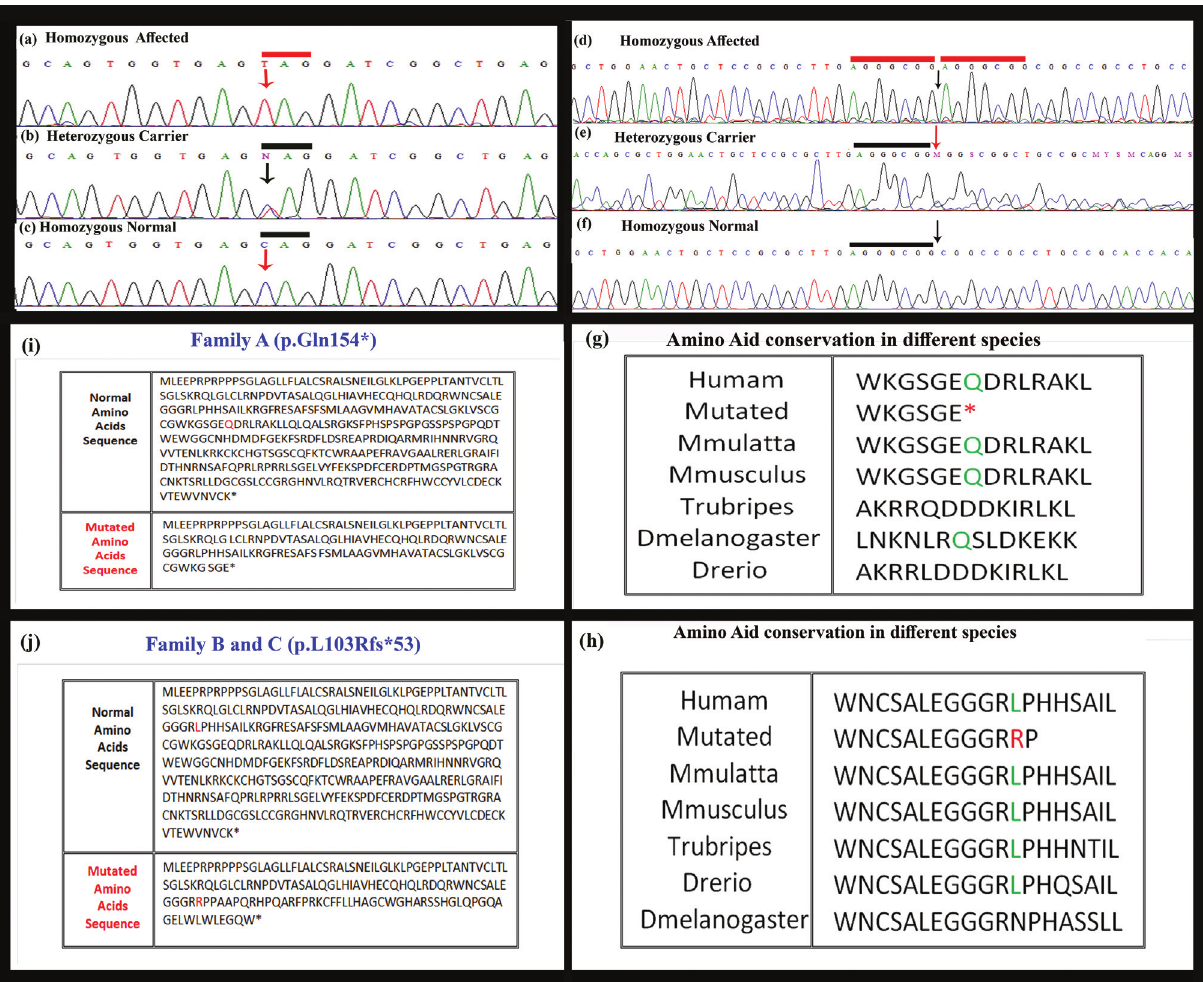
Figure 3 - Sequence analysis of WNT10B gene showing a novel nonsense variant (c.460C > G, p.Gln154*) in affected individuals in family A and B. The upperpanel(a)representsnucleotidesequencesinanaffectedindividual,themiddlepanel(b)inaheterozygouscarrierandlowerpanel(c)inanormalin- dividual; arrows indicate position of the sequence variant. (d) 7-bp duplication mutation (c.300_306dupAGGGCGG; L103Rfs*53) in the gene WNT10B found in affected individuals in family C and D, (e) in the heterozygous carrier, and (f) in an unaffected member of the family. Underline 7-bp sequence AGGGCGG is duplicated in affected members; arrows indicate position of duplication. (g, h) Leucine (L) amino acid represented in green is conserved across four different species. (i) Comparison of amino acid sequence of normal and mutated human WNT10B protein showing nonsense mutation (p.Gln154*) identified in family A and B. (j) Amino acid sequence comparison of normal and mutated human WNT10B protein showing substitution of leucinewitharginineataminoacidposition103andframeshift(Leu103Argfs*53).ComparisonofaminoacidsequenceofhumanWNT10Bproteinwith other